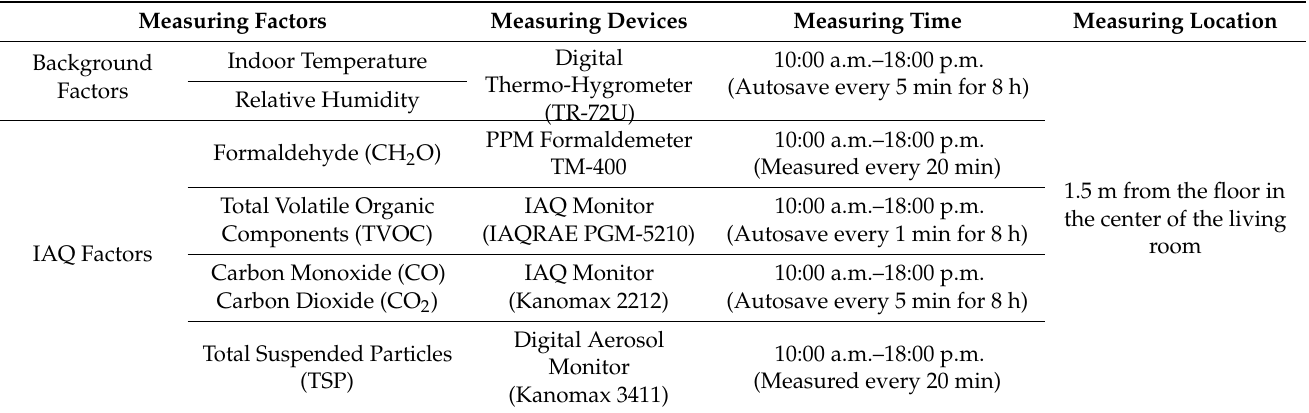
Table 5. Measuring IAQ factors and